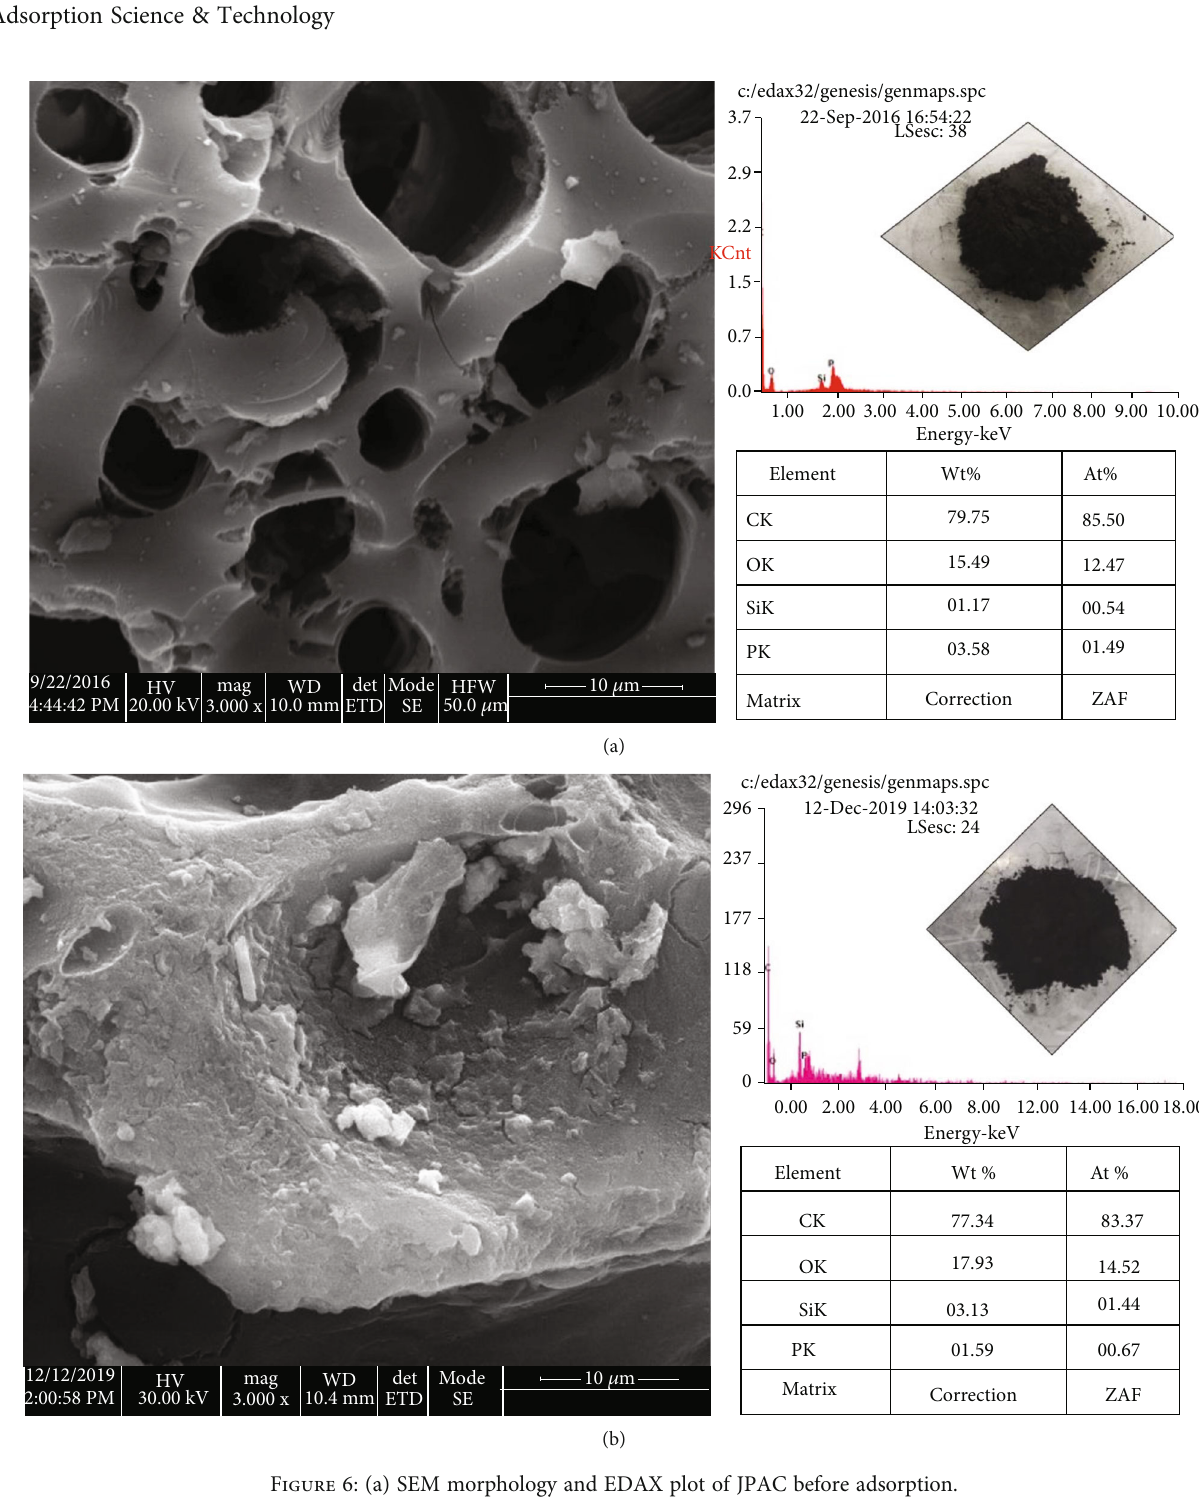
Figure 6: (a) SEM morphology and EDAX plot of JPAC before